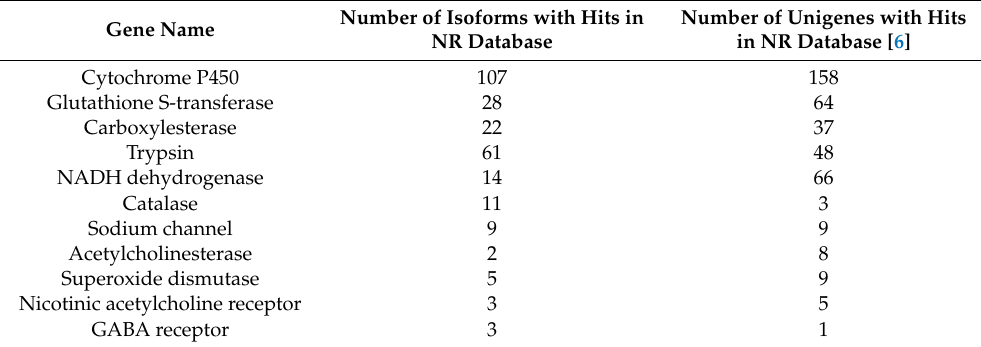
Table 7. Isoforms related to insecticide resistance and metabolism.